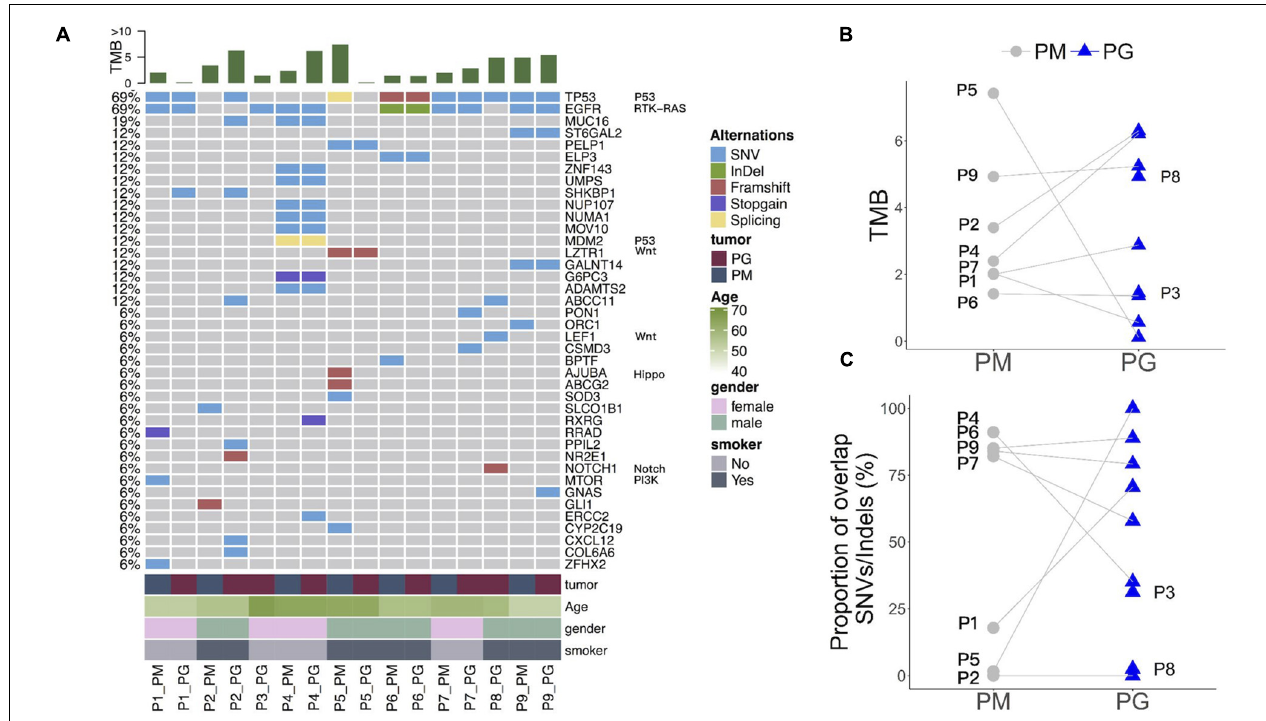
FIGURE 2 | Somatic mutation spectrum and changes of mutation abundance before and after platinum-based chemotherapy treatment of each patient. (A) Somatic mutation spectrum in PM and PG. TMB, gene names and related pathways, and clinical information of each patient are on the top, right, and left of the graph. (B) Changes of TMB in PM and PG. (C) Shared gene mutation proportion in PM and PG. PM, primary specimens; PG, progressive specimens; TMB, tumor mutations burden.